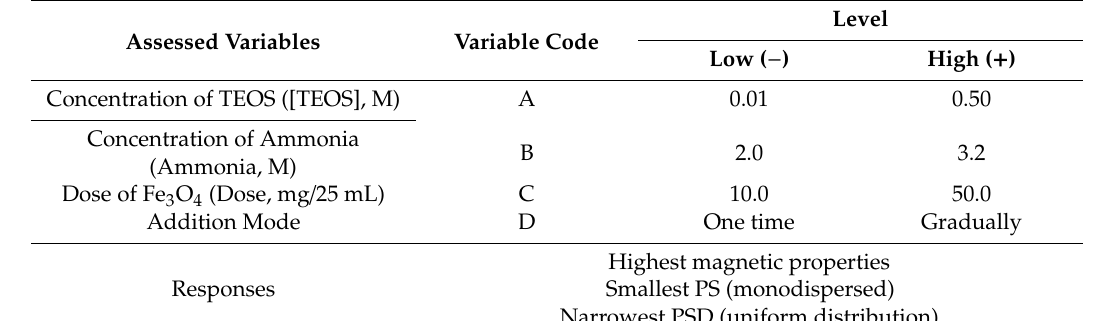
Table 1. Inspected continuous and categorical factors and their domains for a two-level (2 4 ) full factorial design (FFD) instigated for the coating